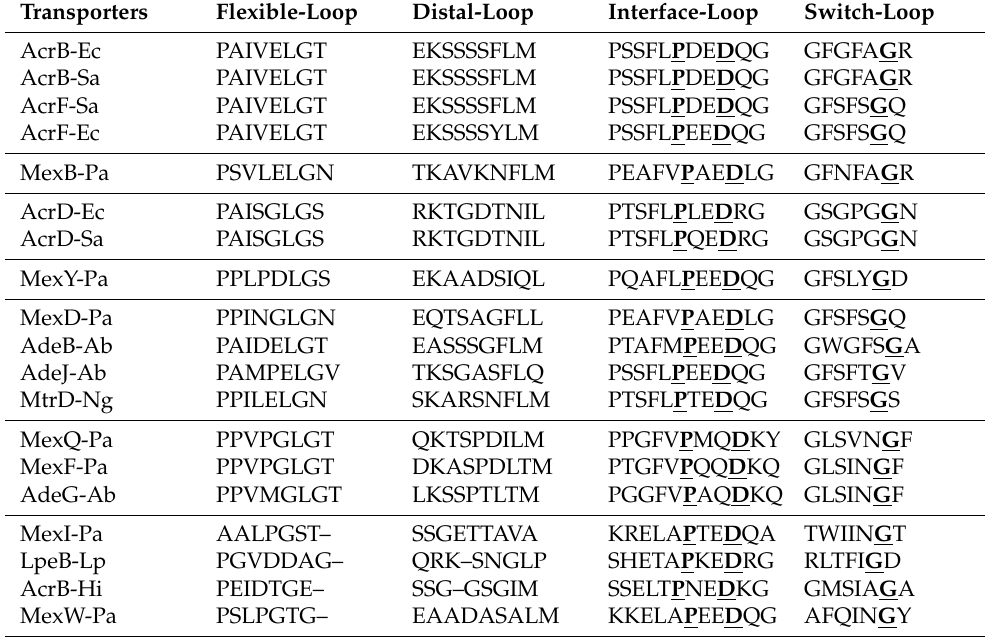
Table 4. Loop sequences of 19 selected